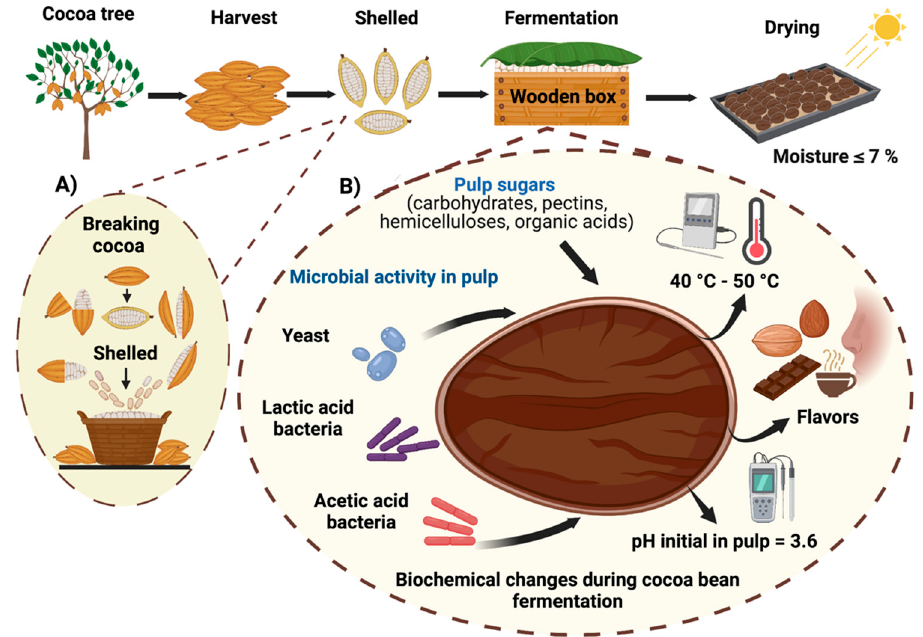
Figure 1. Cocoa bean post-harvest stages. ( A ) After harvest, the cocoa pod is broken and collected and placed in a wooden box for fermentation. ( B ) The cocoa beans are fermented in wooden boxes where autochthonous microorganisms (yeast, LAB, and AAB) produce various metabolites, increase the temperature, decrease the pH of the cotyledon, and trigger the formation of flavor precursors.